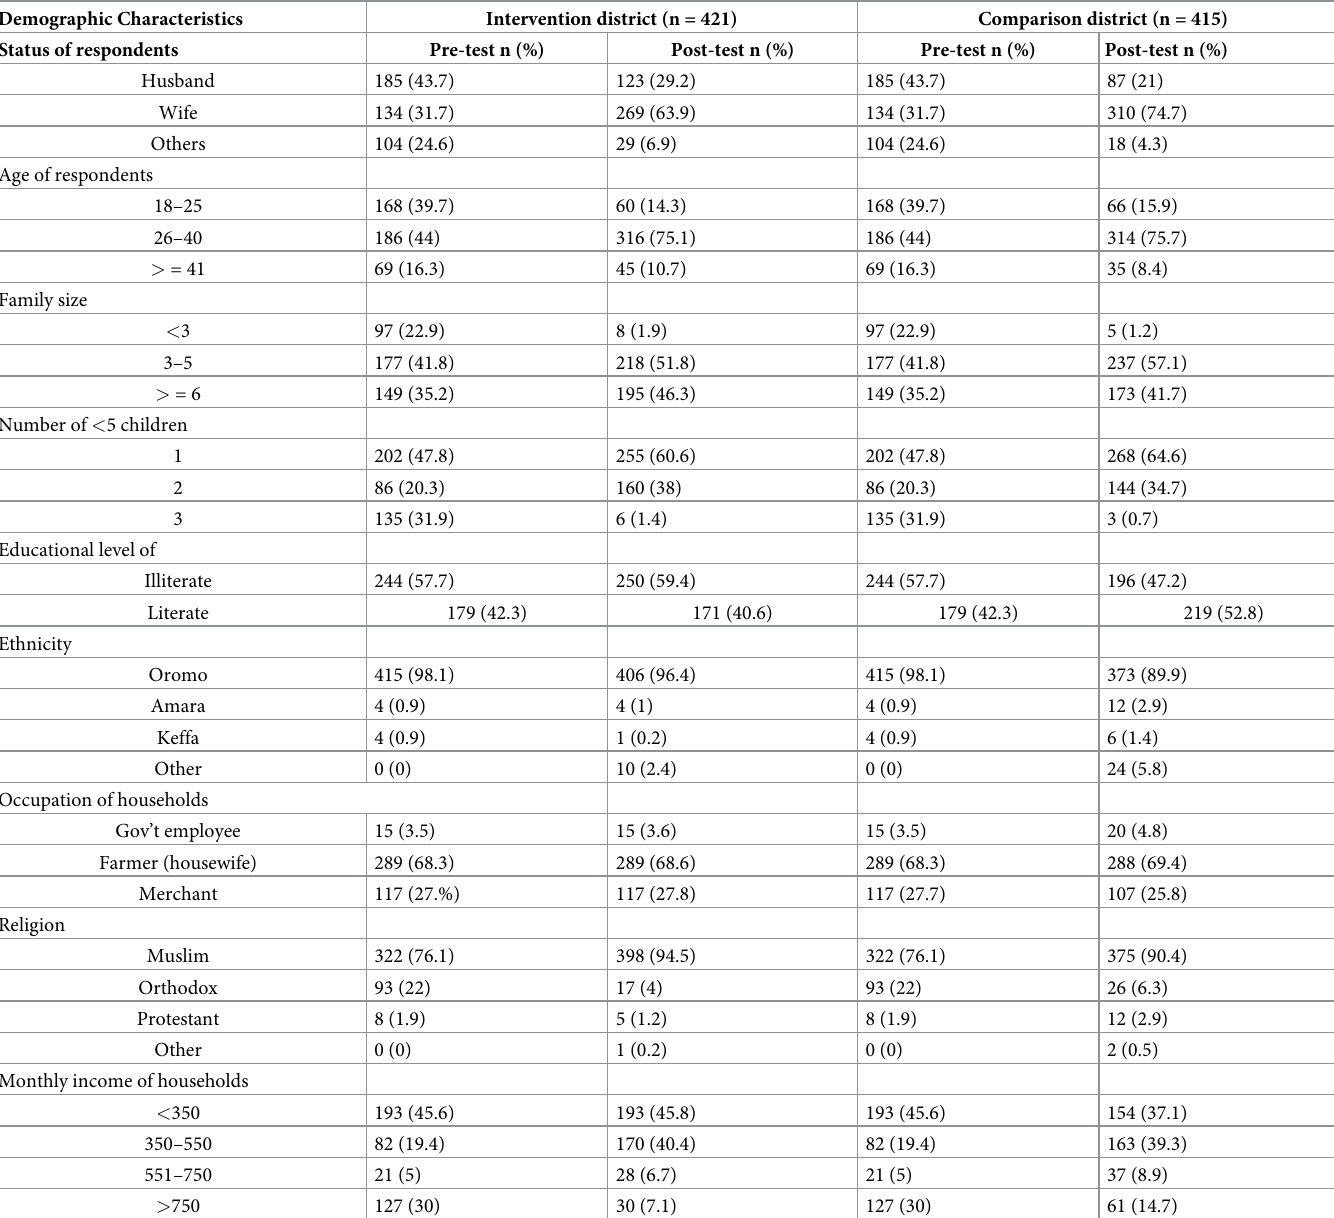
Table 1. Socio-demographic characteristics of study participants in the study districts, Jimma Zone, Oromia Region, Ethiopia, 2019 (N = 836). Demographic Characteristics